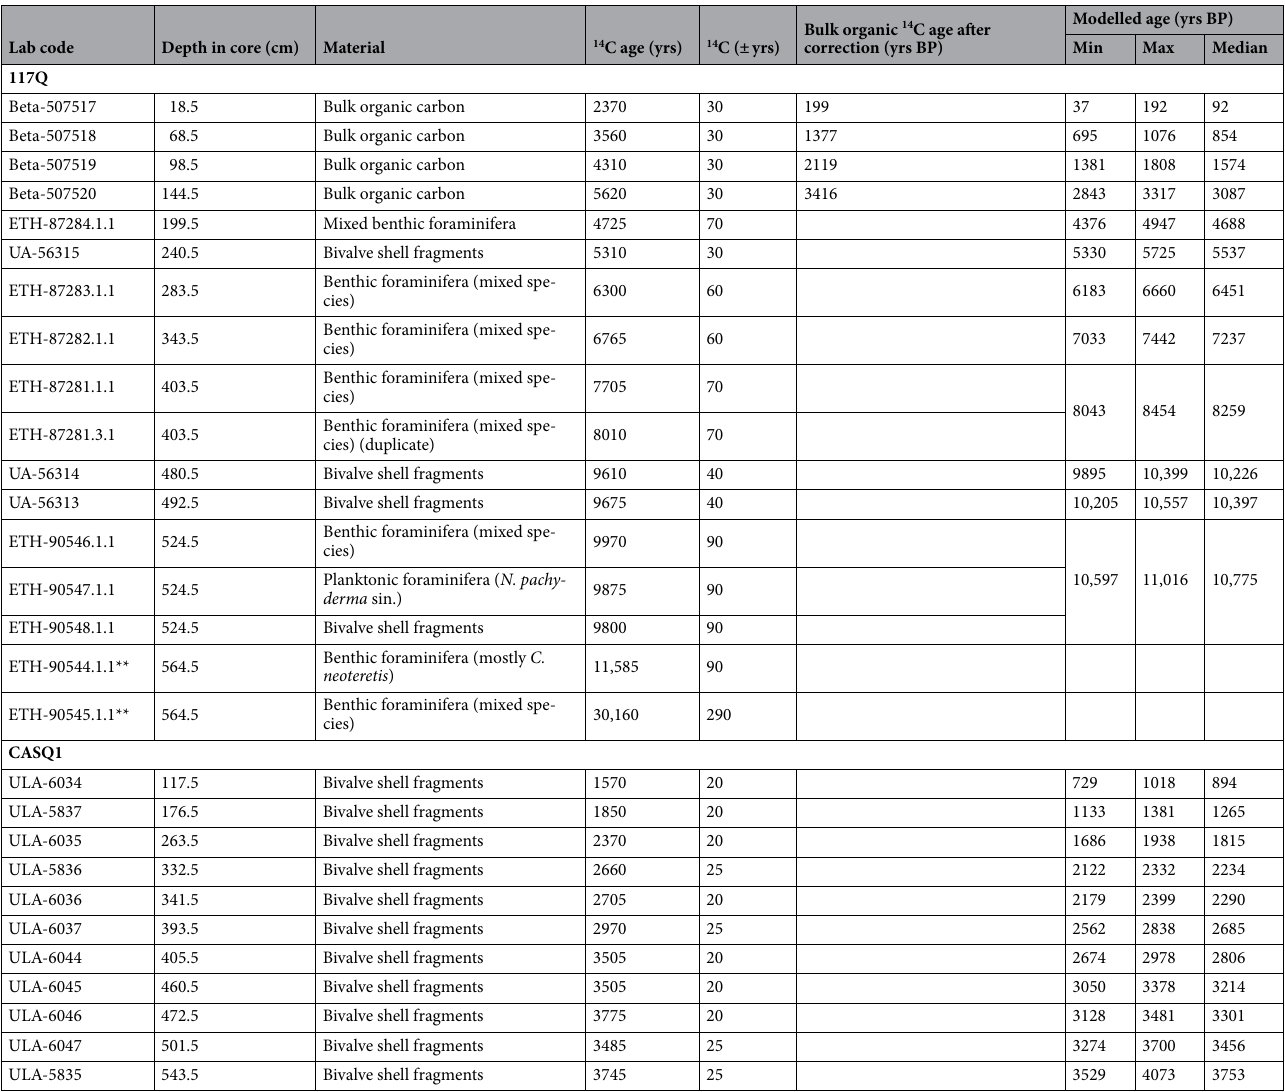
Table 1. Radiocarbon dates and modelled ages for 117Q and CASQ 1. For details on the correction to 117Q bulk organic carbon dates prior to modelling see Supplementary Note 2. All 14 C ages were calibrated using the Marine13 dataset 70 and a local reservoir correction (ΔR) of 140 ± 60 years was applied in the age modelling software BACON 68 . Minimum and maximum ages represent the 95% (2σ confidence interval) in the age model. ** 14 C dates excluded from the age depth